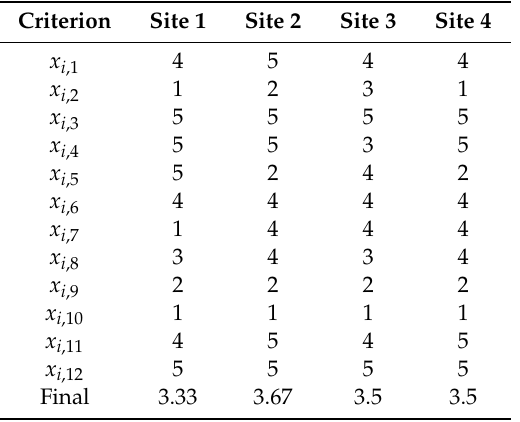
Table 16. Ranking of selected geothermal sites in this study for heat